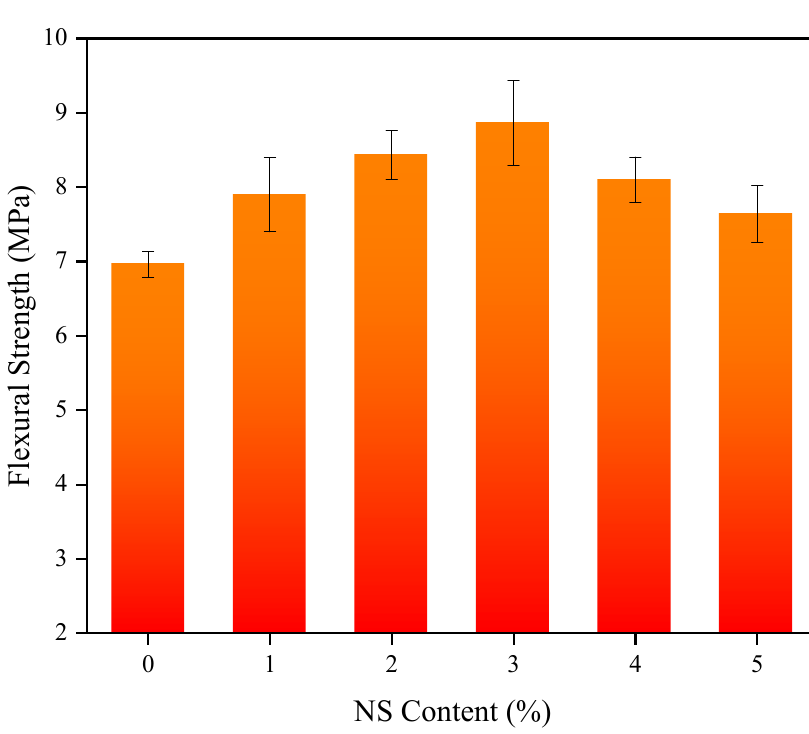
Figure 6. Flexural strength of concrete with NS.